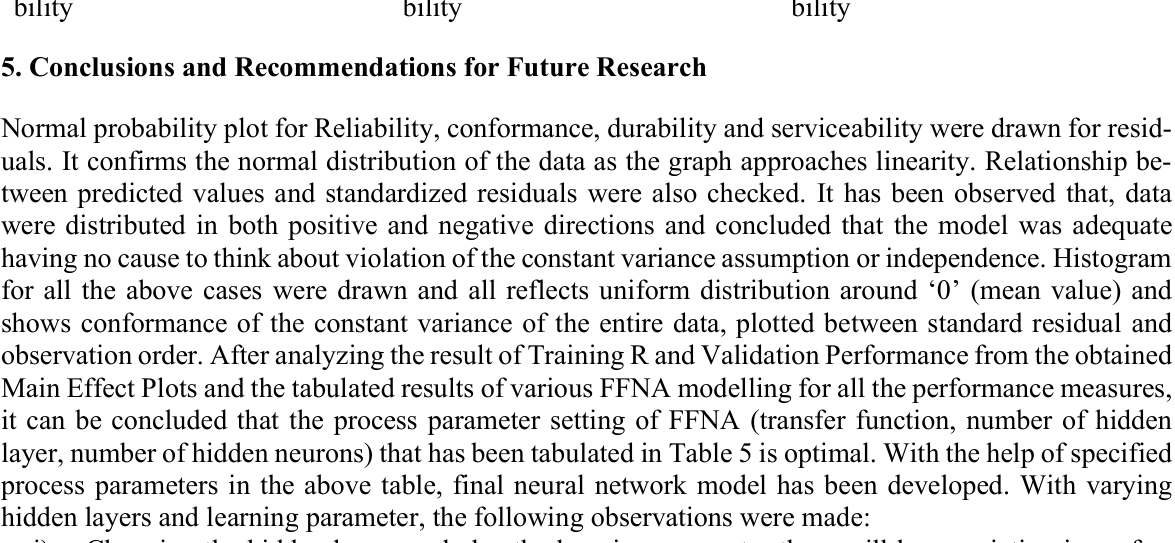
Fig.-13(c). Vendor vs. Servicea-